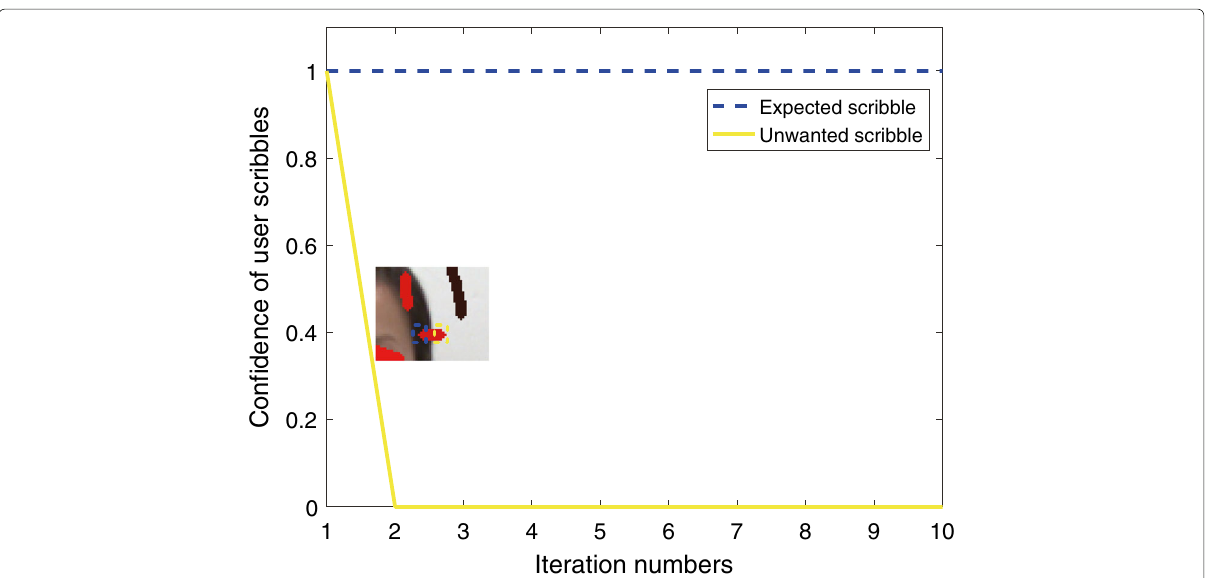
Fig. 3 Change curve of the confidence from user scribbles during iterative solution process where blue and yellow curves are for scribbles inside the blue and yellow rectangles,